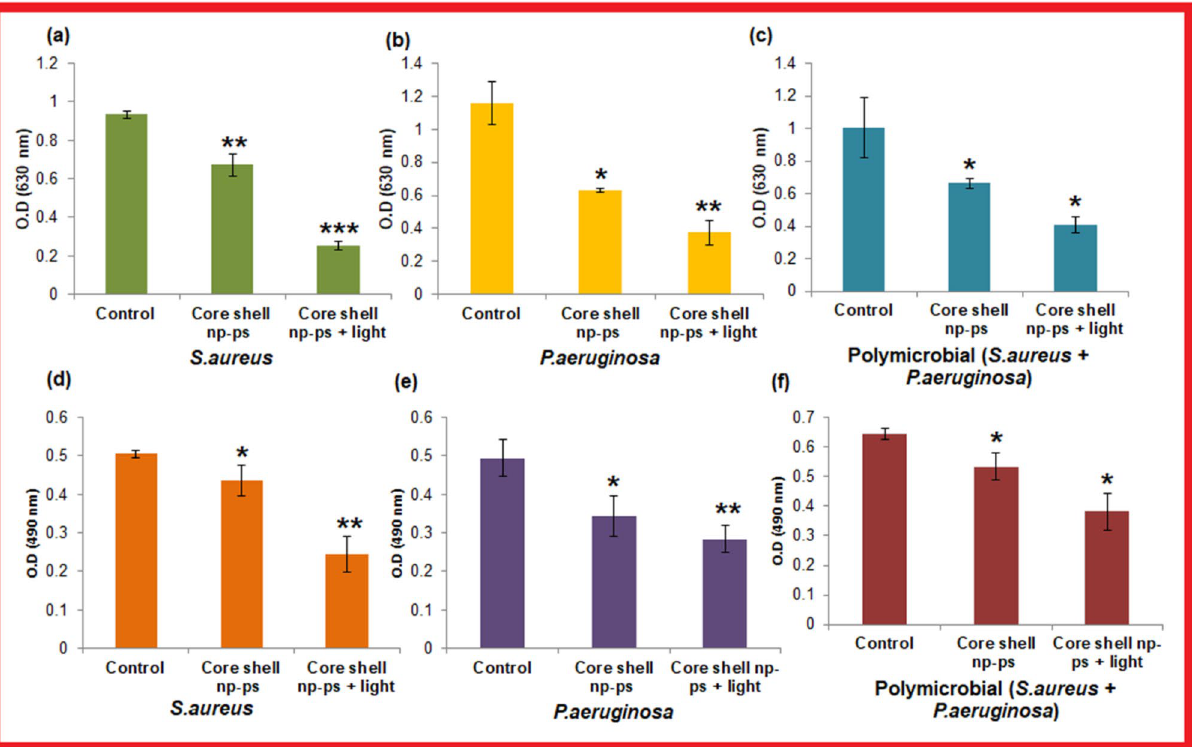
Figure 6. Antibiofilm forming ability of TBO–chit–Au–AgNPs mediated photodynamic therapy: ( a )– ( c ) represents inhibitory effect of TBO–chit–Au–AgNPs mediated PDT on monomicrobial S. aureus , monomicrobial P. aeruginosa and polymicrobial S. aureus + P. aeruginosa biofilms, respectively as quantified by Crystal violet assay. Absorbance was measured at 630 nm. Figure ( d )–( f ) showed effect of TBO–chit–Au–AgNPs mediated PDT on extracellular polysaccharide substance (EPS) reduction as quantified by Congo-red assay. Absorbance was measured at 490 nm. The data represent an average of triplicate experiments ± SD. ( p